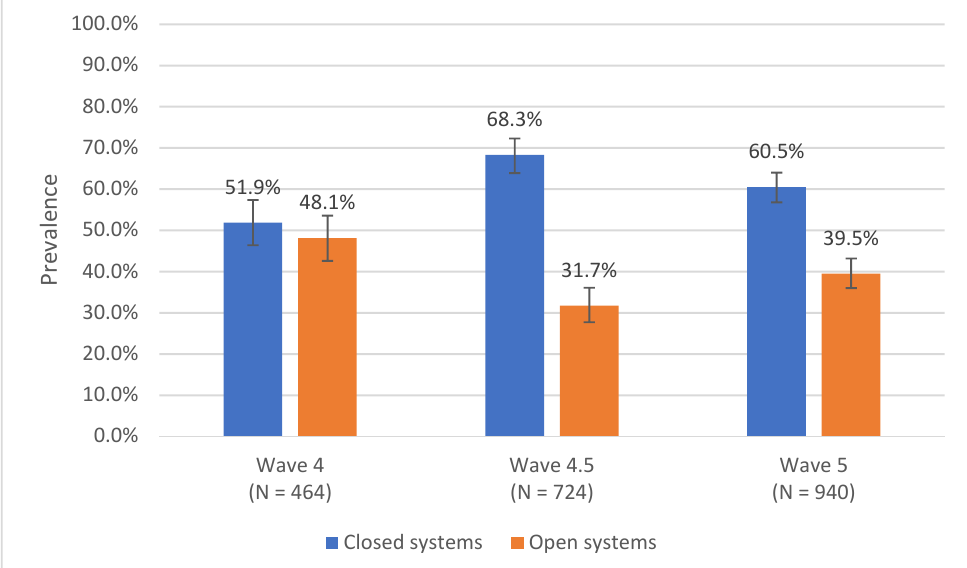
Figure 1. Prevalence of closed and open systems in youth not-light current ENDS users, PATH Study Waves 4, 4.5, and 5 a,b . Compared to open system use, the odds of closed system use for each one wave increase was 1.11 times (95% CI: 0.97, 1.28) the odds of closed system use at the previous wave ( p = 0.132) c . a Current ENDS use is any ENDS use in the past 30 days. Not-light current ENDS users used ENDS more than once in their lifetime. For device type—Waves 4 and 4.5: Closed systems are devices that are not rechargeable, or devices that are rechargeable and use cartridges; open systems are devices that are rechargeable, do not use cartridges, and are refillable. Wave 5: Closed systems are disposable e-cigarettes or e-cigarettes that use pre-filled pods or cartridges; open systems are e-cigarettes with a refillable tank or mod systems. Device type categorization for Wave 5 includes not-light current ENDS users only (i.e., the primary analytic population). b Wave 4 is 2016–2017, Wave 4.5 is 2017–2018, and Wave 5 is 2018–2019. For each wave, percentage estimates of the prevalence of primary closed and open system ENDS use are weighted. Ns presented are unweighted. c Unadjusted logistic regression was used to test for a trend (cross-sectional) in the prevalence of primary closed system ENDS use (compared to open system) across waves. Abbreviations: ENDS = Electronic nicotine delivery system; PATH = Population Assessment of Tobacco and Health.